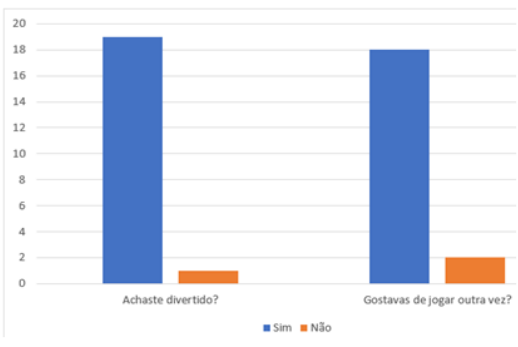
Figure 12. Students’ answers to the questions. The blue color (on the left) is for “yes” and the orange color (on the right) for